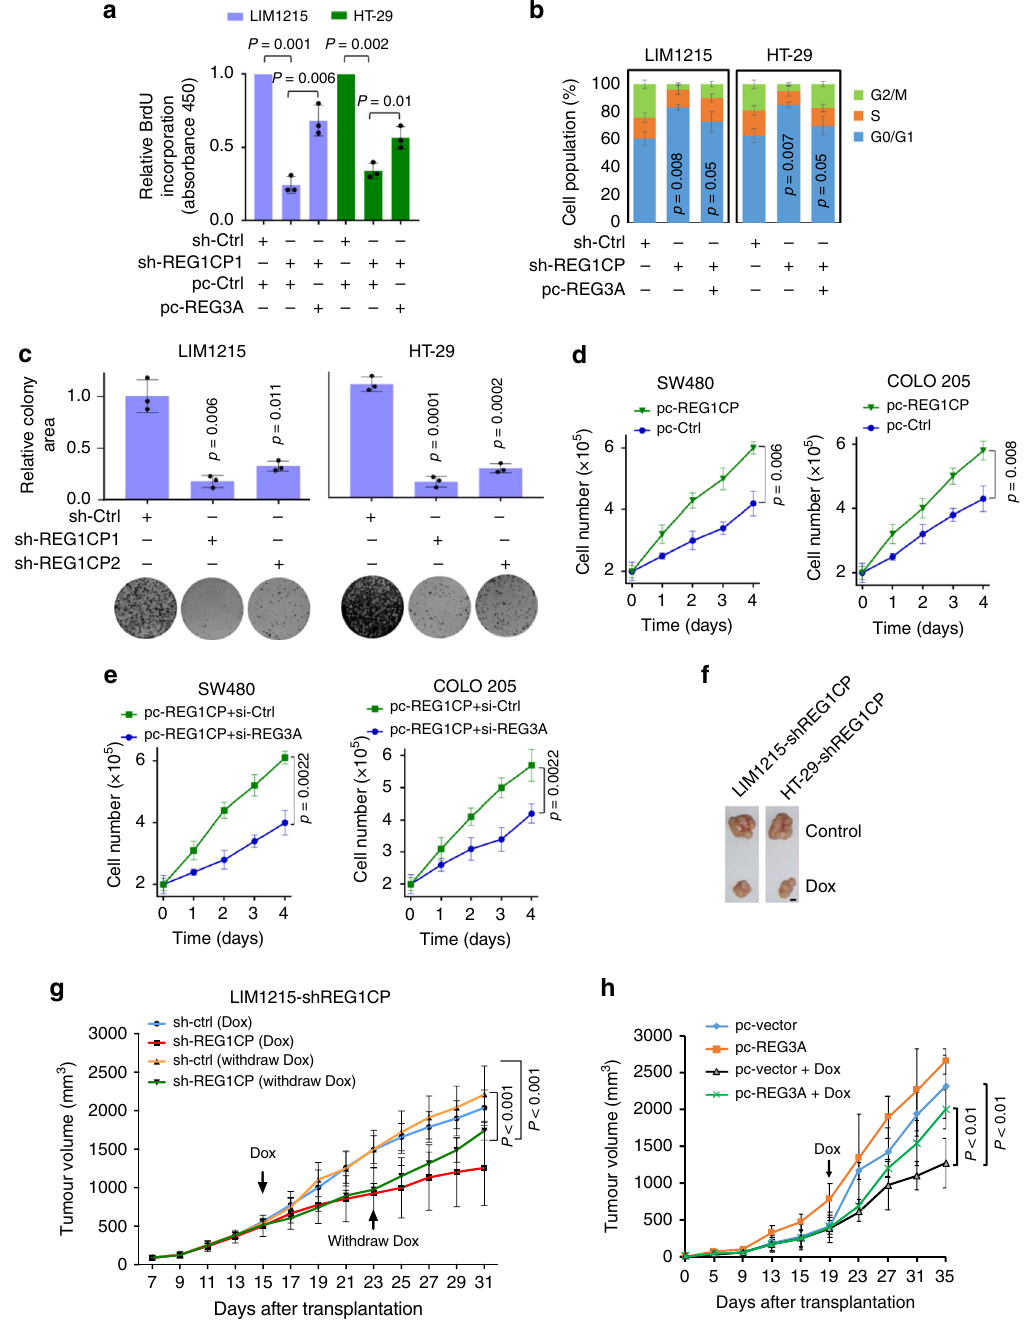
Fig. 3 REG1CP promotes cancer cell cycle progression and tumorigenicity through REG3A. a REG3A overexpression reversed the inhibitory effect of REG1CP silencing on BrdU incorporation. b REG3A overexpression reversed G0/G1 cell cycle arrest caused by REG1CP silencing. Relative cell cycle distribution was quantitated by propidium iodide staining using fl ow cytometry in cells transduced with the control or REG1CP shRNA1 with or without overexpression of REG3A. c Silencing of REG1CP inhibited clonogenicity. Relative clonogenicity of cells transduced with the control or REG1CP shRNAs was quantitated using ImageJ-plugin “ ColonyArea ” . d Overexpression of REG1CP promoted cell proliferation. SW480 and COLO205 cells with or without overexpression of REG1CP were counted using an automated cell counter. e Silencing of REG3A reversed promotion of cell proliferation caused by REG1CP overexpression. SW480 and COLO205 cells overexpressing REG1CP transduced with the control or REG3A shRNA were counted using an automated cell counter. f , g Silencing of REG1CP inhibited colon cancer xenograft growth in nu/nu mice. Representative photographs ( f ) and growth curves ( g ) of LIM1215-shREG1CP xenografts in mice with or without treatment with doxycycline (Dox) and with or without Dox withdraw to induce silencing of REG1CP. n = 6 mice per group. h Overexpression of REG3A reversed the inhibitory effect of REG1CP silencing on colon cancer xenograft growth. Growth curves of LIM1215-shREG1CP xenografts with or without overexpression of REG3A in mice with or without treatment with doxycycline (Dox) to induce silencing of REG1CP. n = 6 mice per group. n = 3 independent experiments unless speci fi ed differently. Data are presented as Mean ± SEM ( a , b , c (upper), d , e , g , h ) or representatives ( c (lower) and f ). Statistical signi fi cance was calculated using a two-tailed t